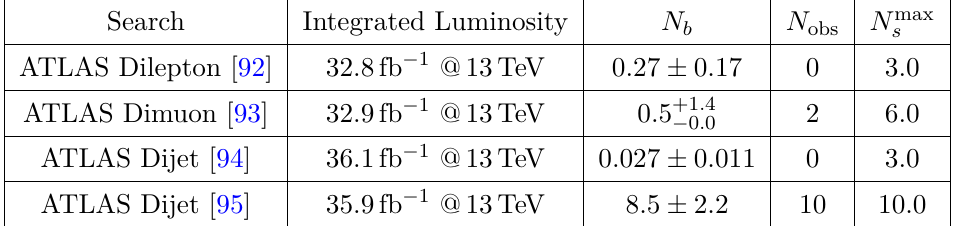
, obtained from s